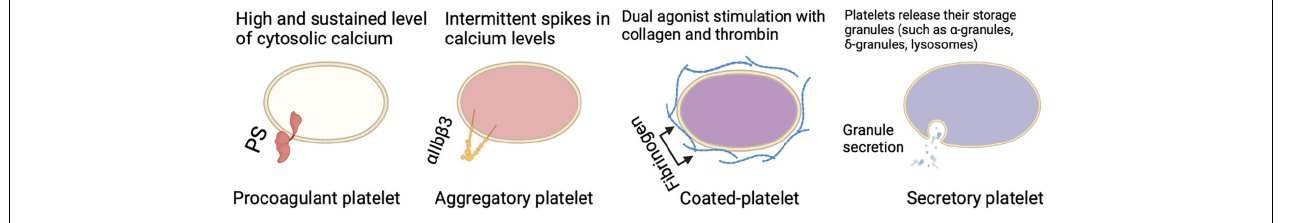
FIGURE 1 | Different circulating platelet subtypes each perform a certain role in different settings and participation in thrombus